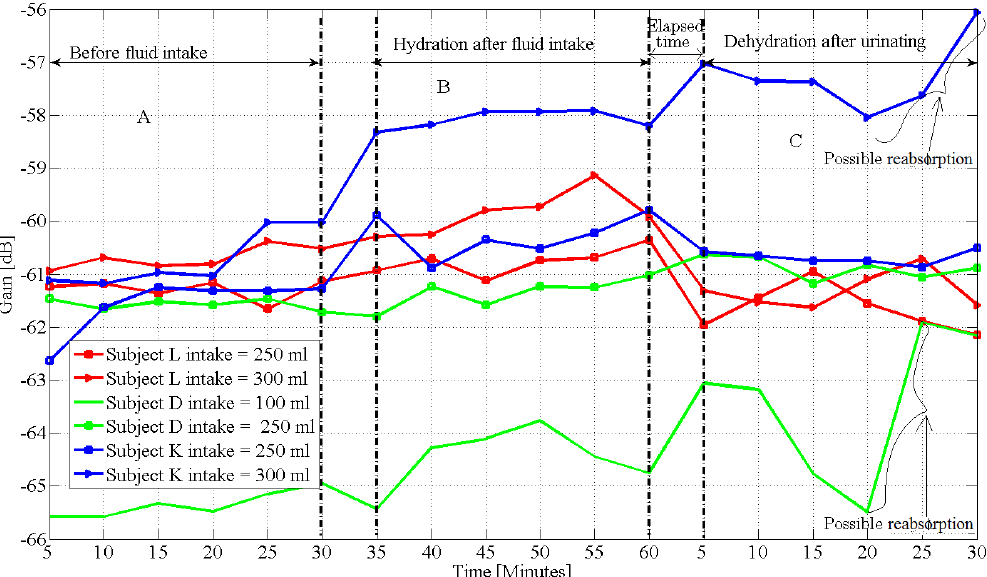
Figure 3. Graph of the sensitivity test of an intrabody signal measured on subjects L, D, K at 3 random days measured at 900 kHz, before drink ( A ), after drinking 100 mL, 250 mL and 300 mL amounts of water ( B ), and after urinating ( C